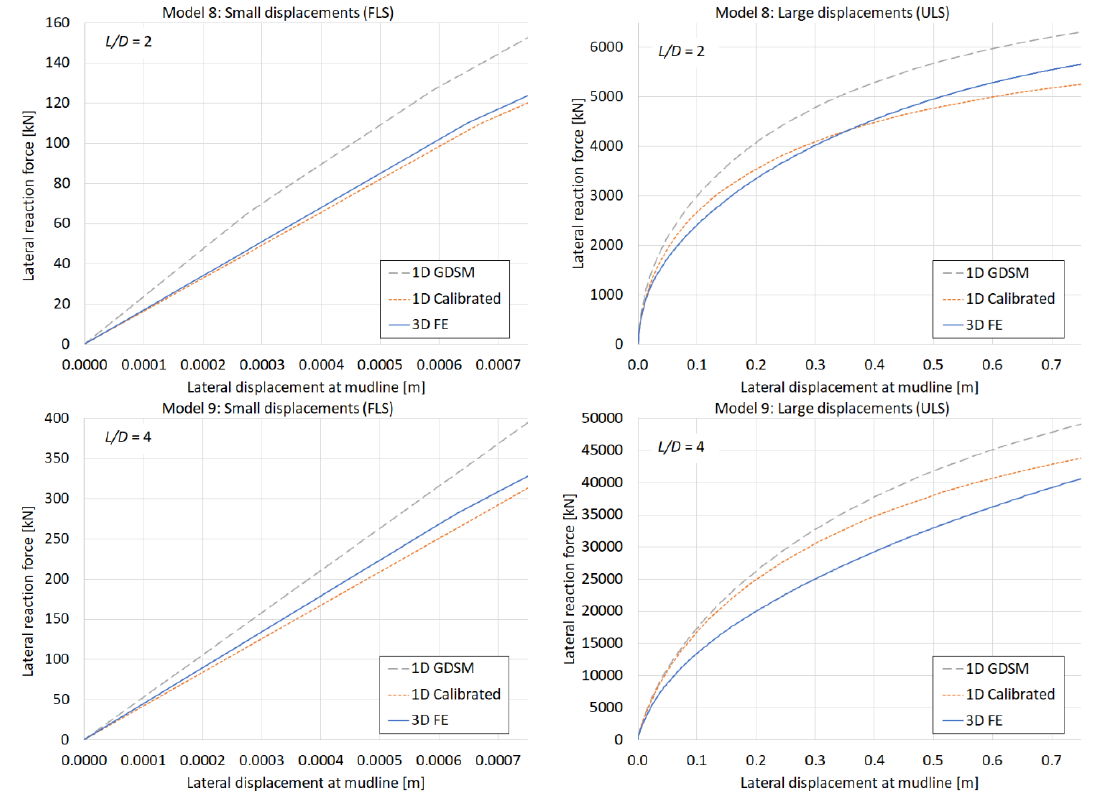
Figure A1. Load-displacement curves for Models 1–9 as listed in Table 3. Table A1. Accuracy metric η for difference between 3D FE and 1D Calibrated results.